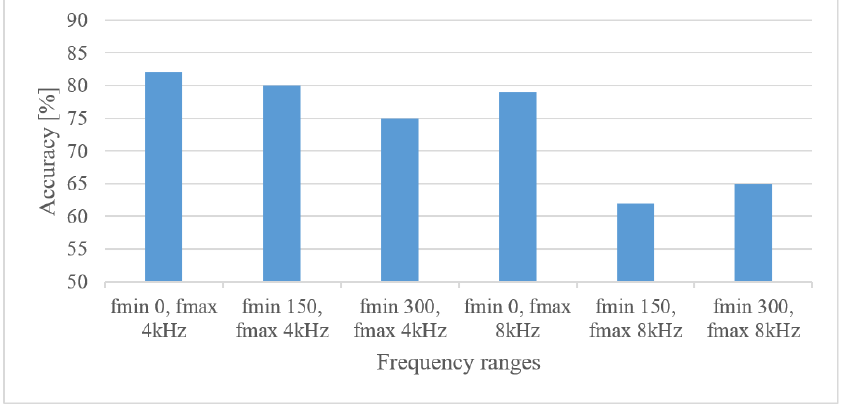
Figure 11. Accuracies for minimal and maximal frequency limits.